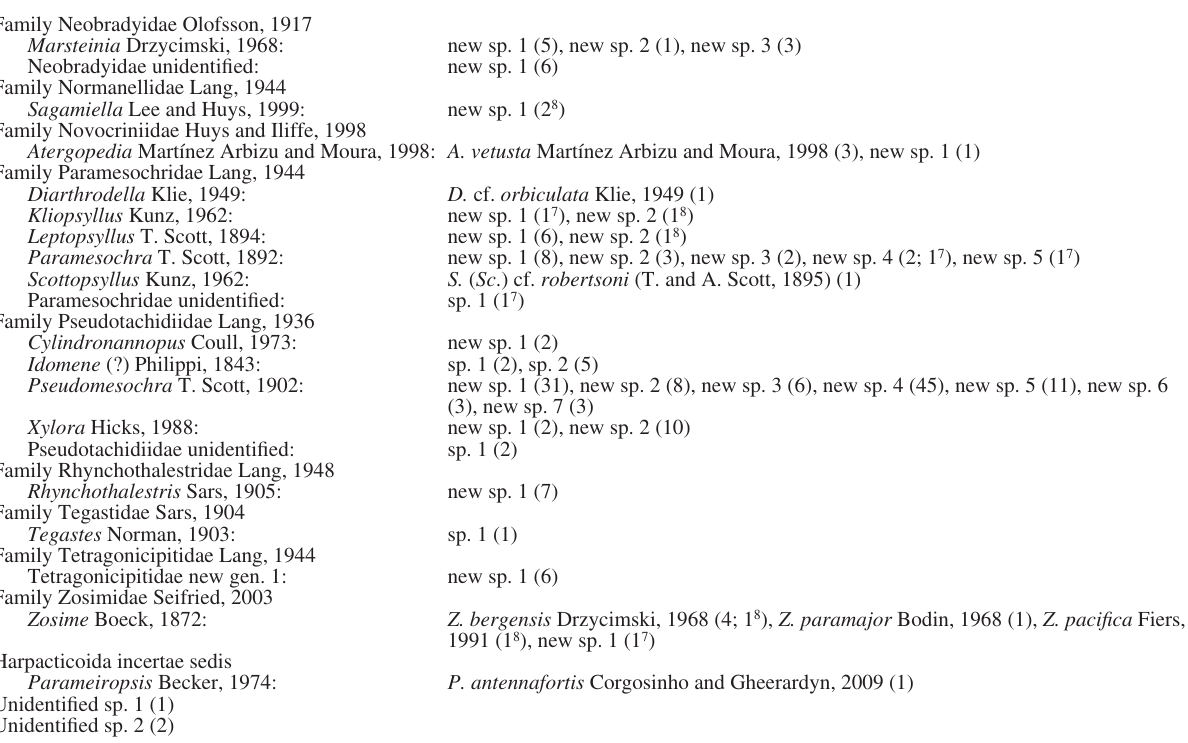
Table 2 (cont.). – list of identified families, genera and species from the Porcupine seabight. For each species, the number of collected specimens from the coral degradation zone is given (between parentheses). number of collected specimens from coral-free sites 7 and 8 are provided separately ( 7 or 8 : from coral-free site 7 or 8,